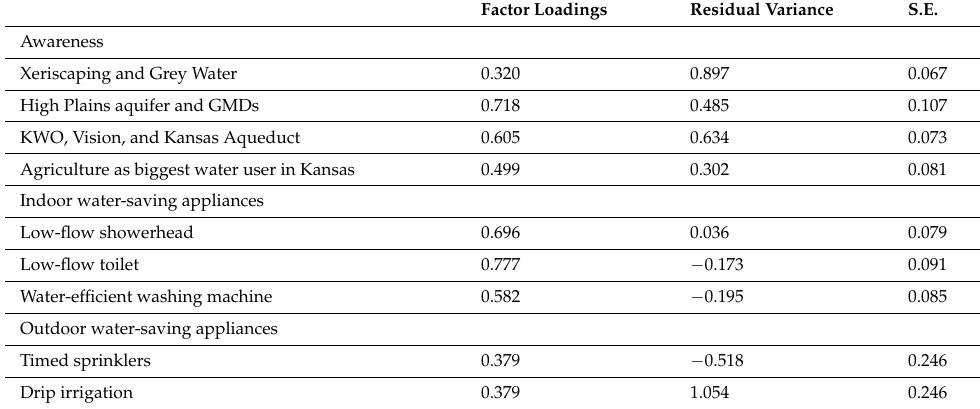
Table A7. Standardized model results of owning water-saving appliances for appliances for indoor and outdoor usage regressed on awareness levels for lawn and garden well owners (n = 135).